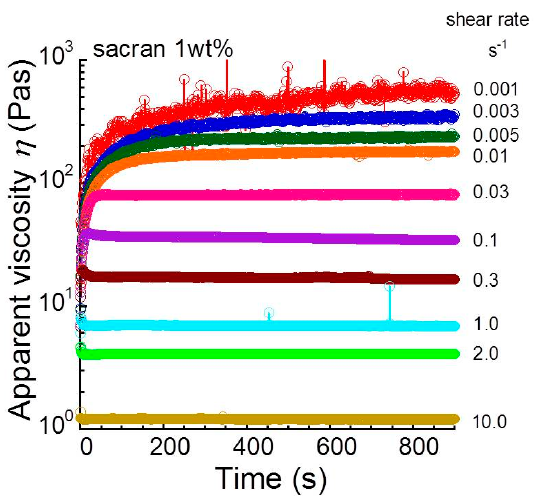
Figure 1. Time profiles of apparent shear viscosity for 1 wt.% sacran aqueous solution as a function of shear rates.